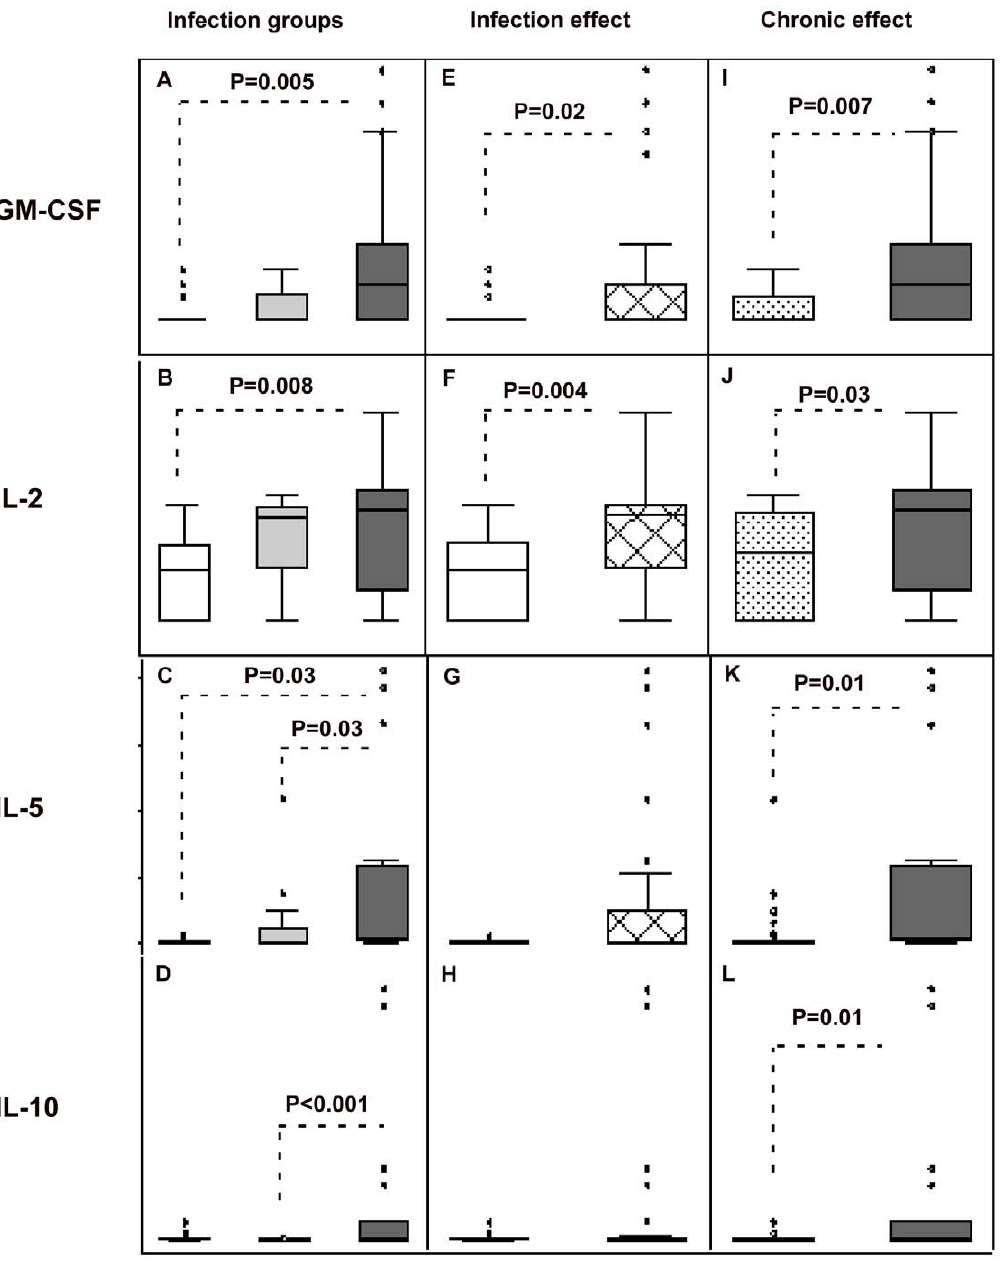
Figure 1. Production of cytokines, GM-CSF, IL-2, IL-5, and IL-10 by unstimulated peripheral blood mononuclear cells. Figures 1A–D: STH infection groups - uninfected (clear boxes), light (light grey), and chronic (dark grey) infections. Figures 1E–H: STH infection effect – uninfected (clear) and infected (hatched). Figures 1I–L: chronic STH infection effect: non-chronic [light infection group + uninfected]) (dotted) and chronic (dark grey) infections. Shown are box plots with median (central line), inter-quartile range (box margins), and 95% confidence intervals (bars). Cytokine concentrations are pg/mL. Only comparisons with P , 0.05 are shown. P values in Figures 1A–D are corrected for multiple comparisons.